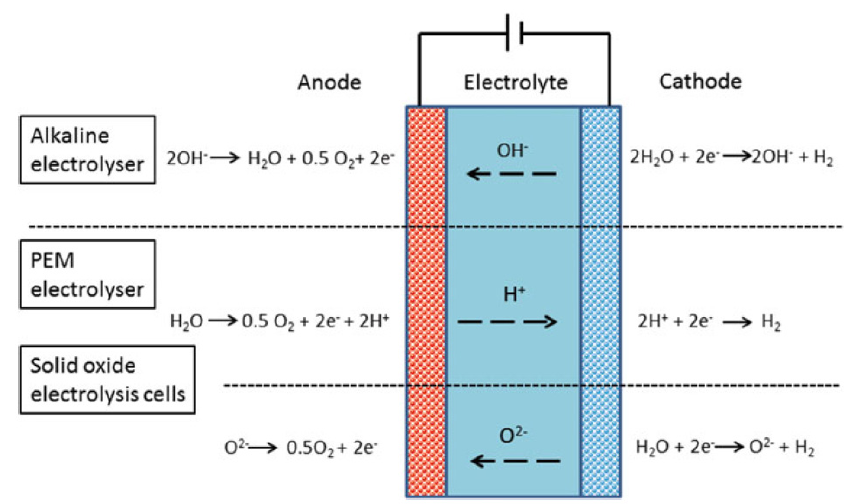
Figure 2. Classification of water electrolyzers [24].